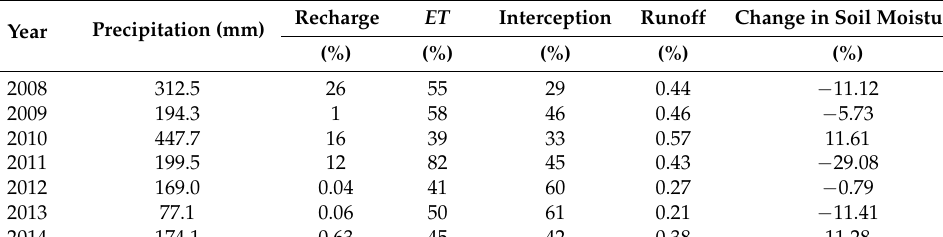
Table 6. Water Balance Parameters as % of Gross Precipitation.